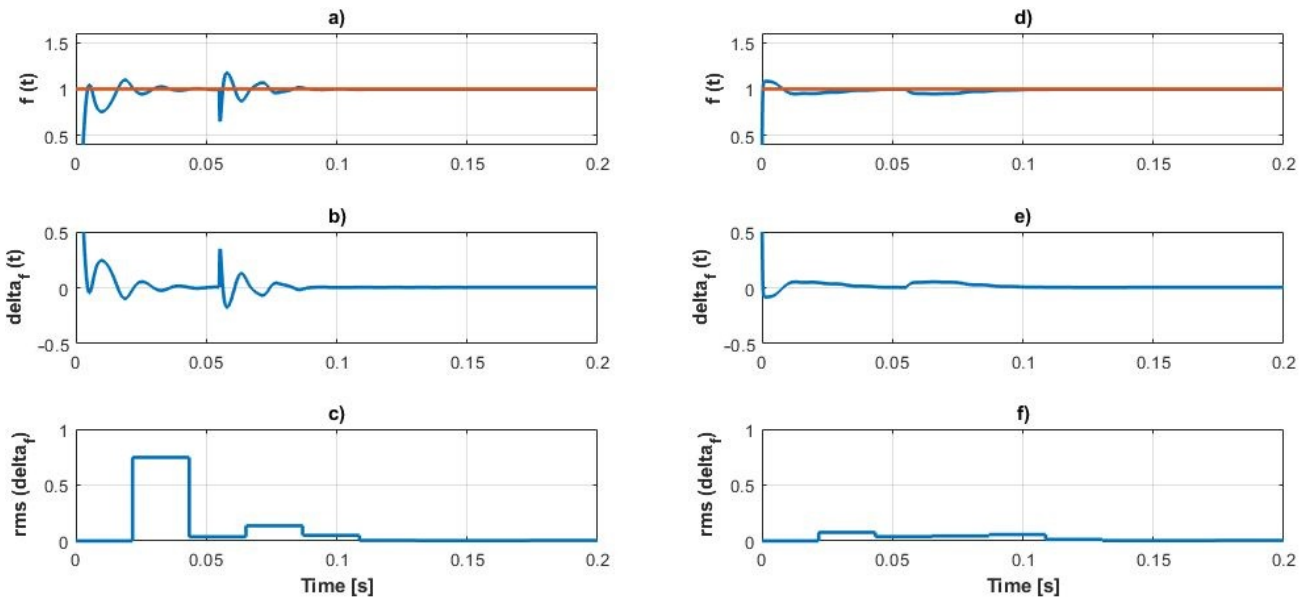
Figure 14. Frequency estimation during short-circuit for DDSRF–FLL ( a – c ) and DSOGI-FLL ( d – f ) where: ( a , d ) frequency estimated value (orange—reference, blue—tested algorithm), ( b , e ) frequency error between compared algorithms, and ( c , f ) RMS value-form frequency error.